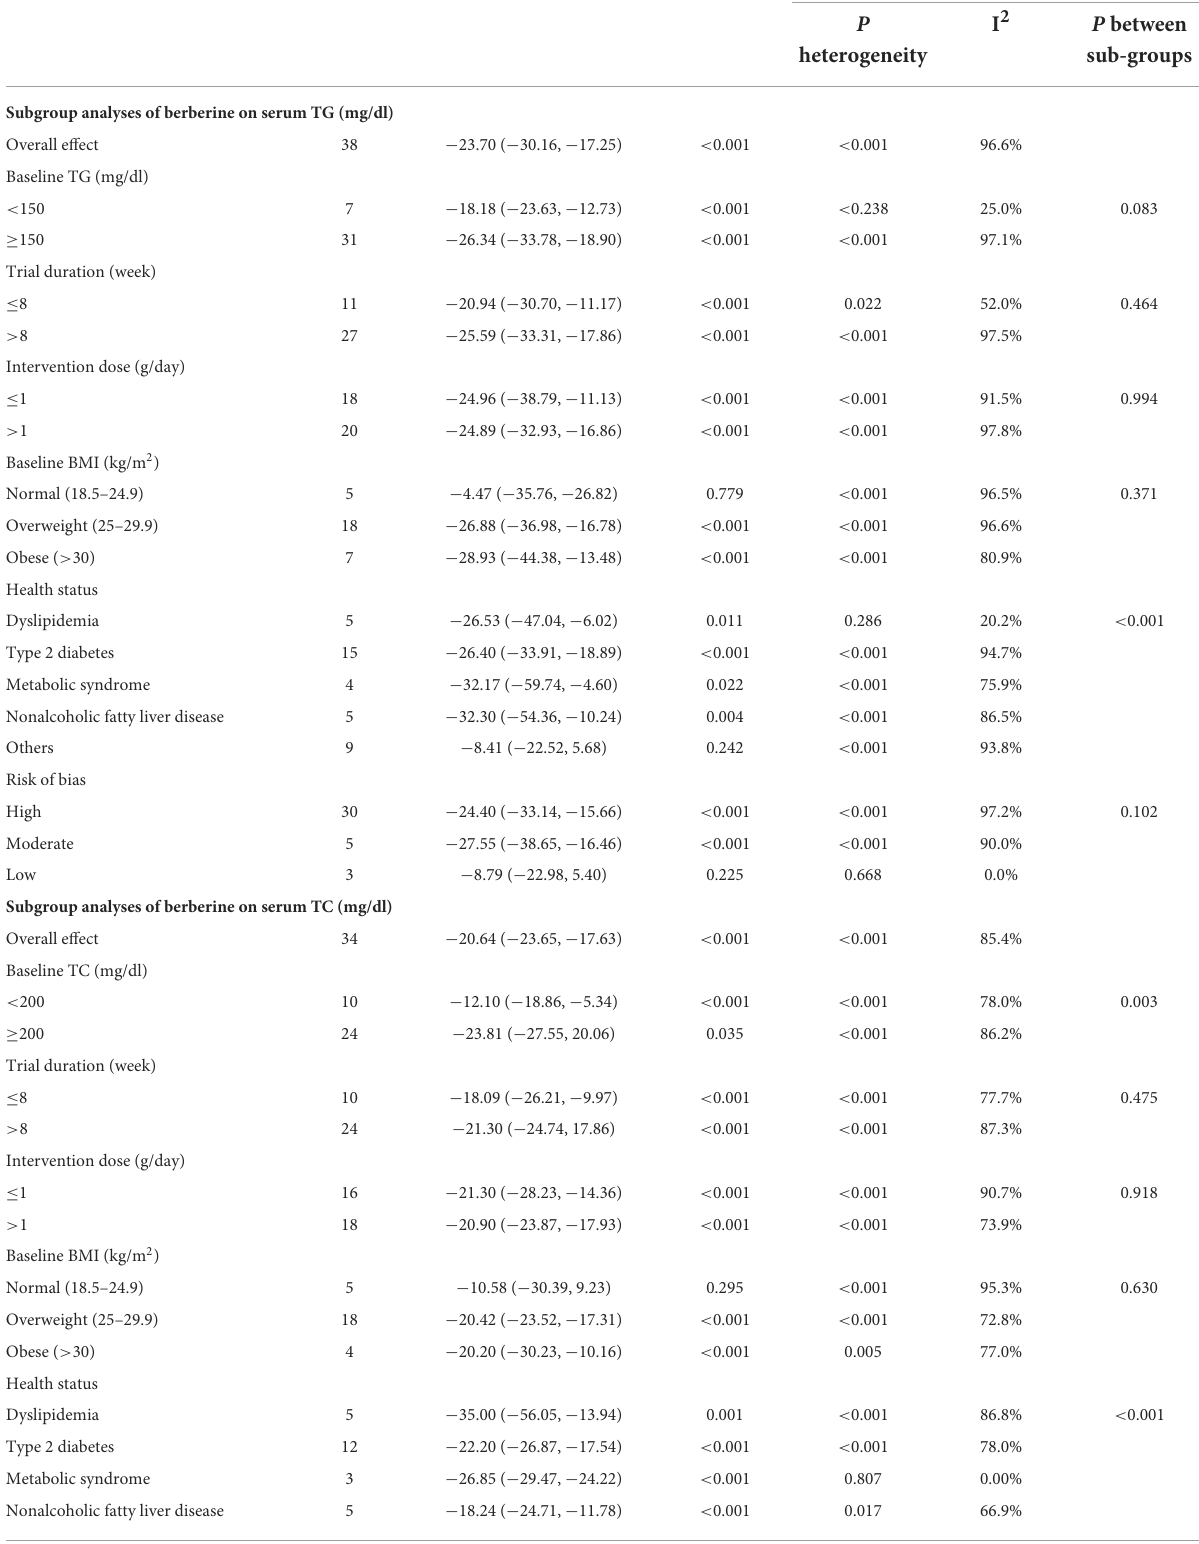
TABLE 3 Subgroup analyses of berberine supplementation on cardiovascular risk factors in adults. No WMD (95%CI) P -value Heterogeneity